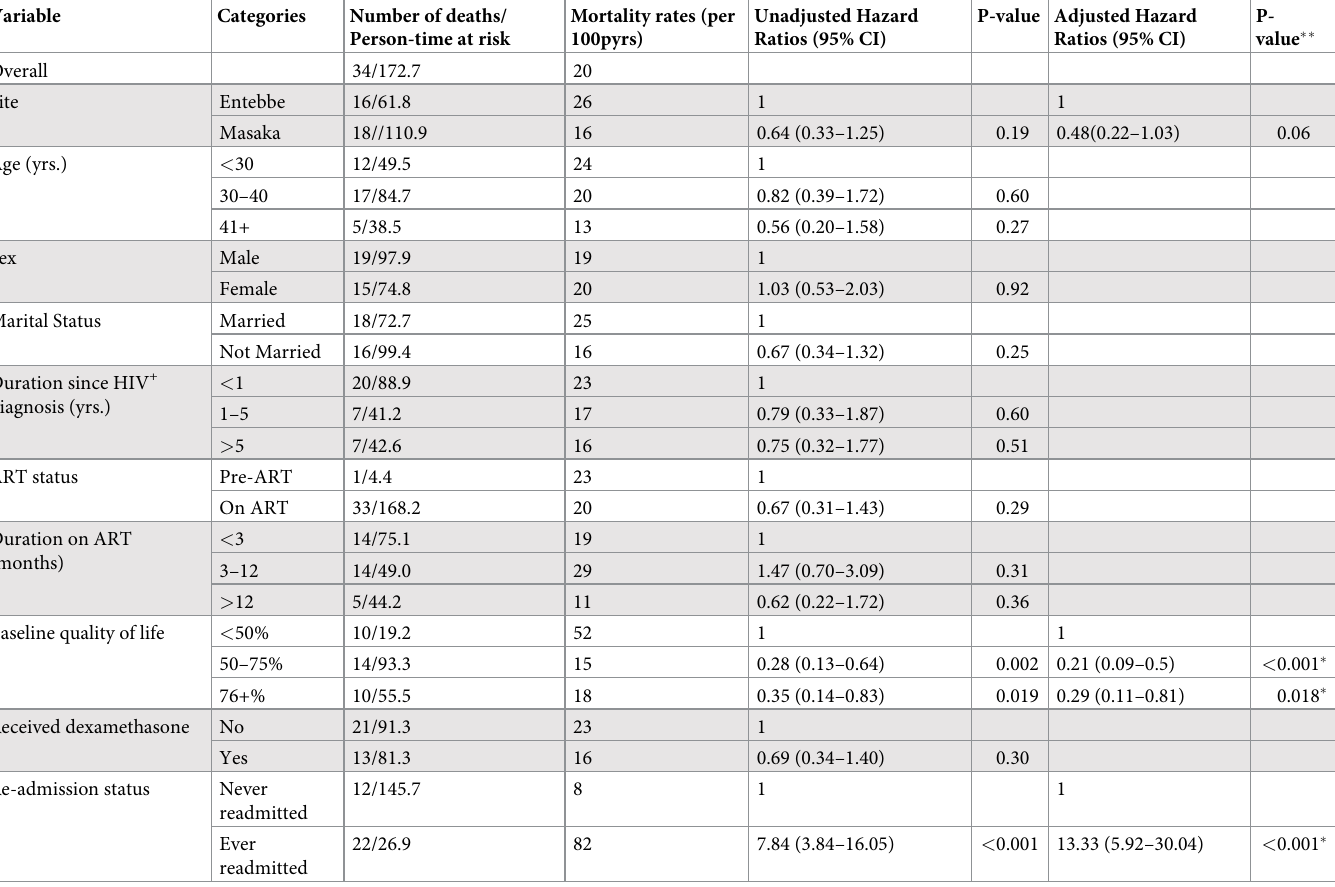
Table 2. Mortality rates, bivariate and multivariate analysis showing factors affecting